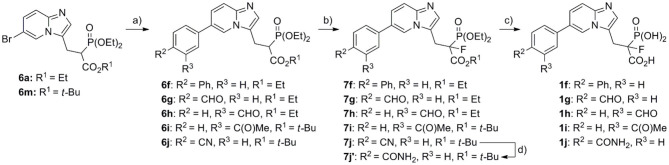
Reagents and conditions: (a) appropriate boronic acid, Na2CO3, Pd(PPh3)4, toluene:EtOH:H2O (2:1:2), yield 67–83%; (b) NaH, NFSI, THF, −70°C/20 min, then rt/overnight, yield 20–77%; (c) for compounds 1f−1i: 12 M HCl, 5 h, reflux, yield 65–77%; for compound 1j: (I) 7j′, BTMS, ACN, 24 h, 35°C, (II) EtOH, 15 min, rt, (III) trifluoroacetic acid, 2 h, rt, yield 66%; (d) H2O2, DMSO, EtOH, 24 h, rt, yield 57%.